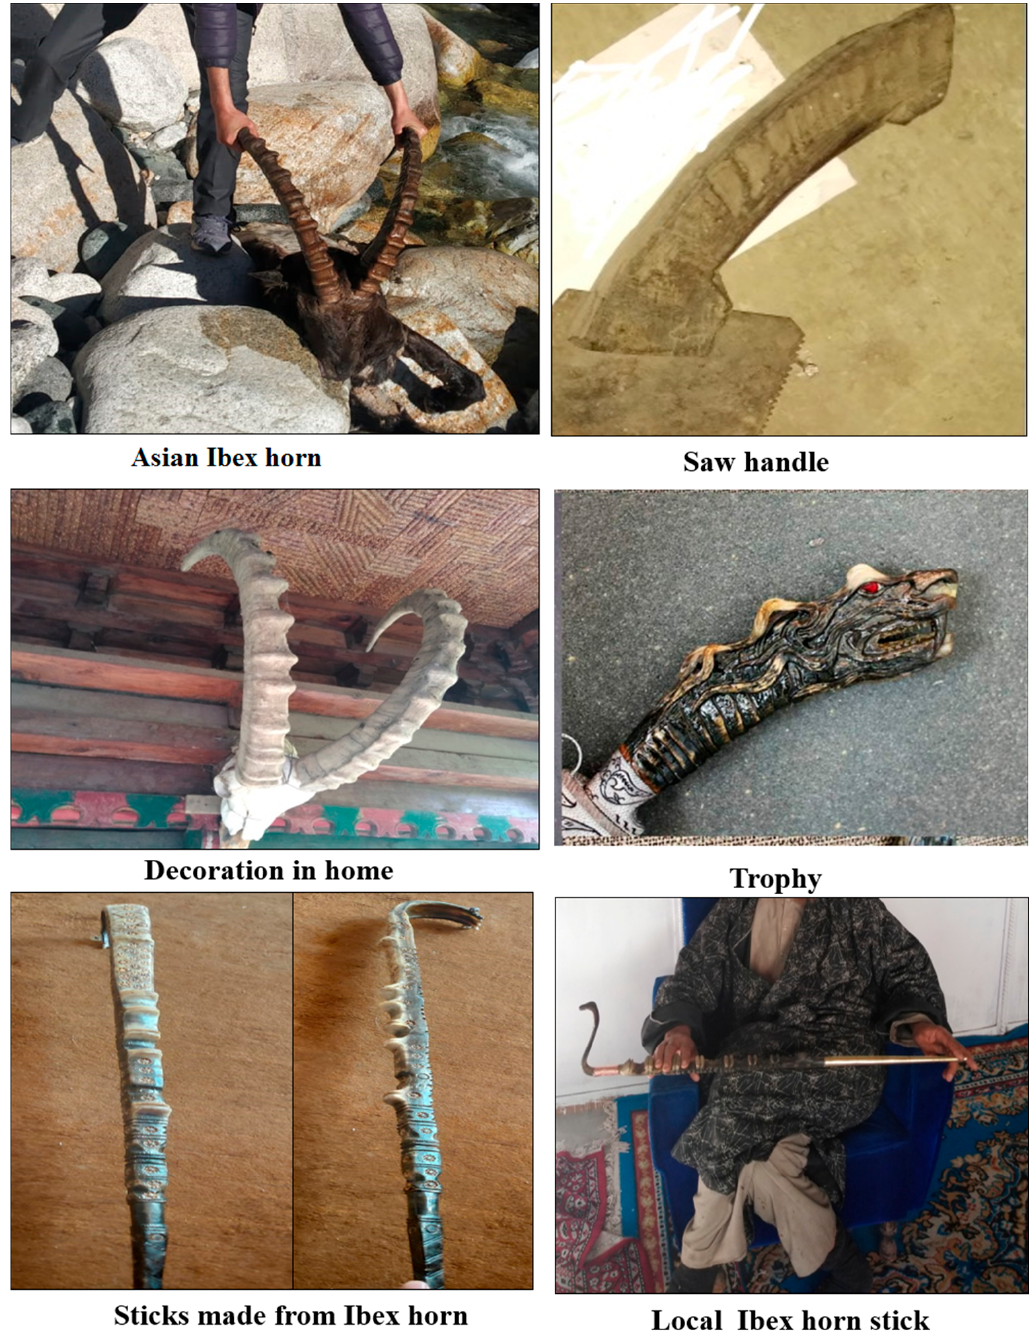
Figure 3. Uses of different part of wild animals.